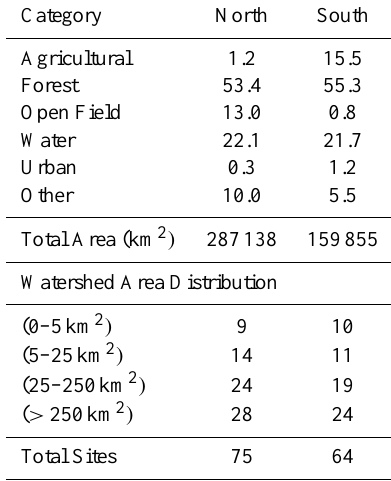
Table 2. Watershed area distribution (number of sites) and land use (%) for study sites by region in